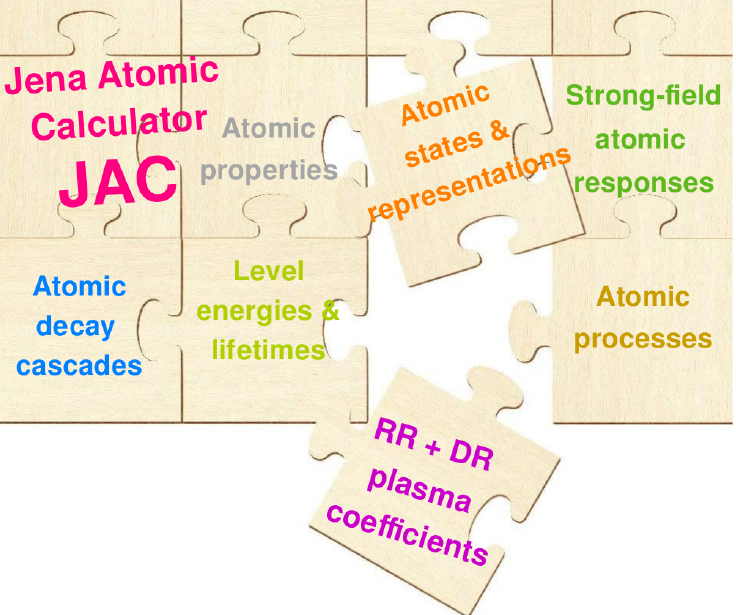
Figure 1. Selected features of the J AC toolbox [21] that help compute the level structure, processes and cascades of most atoms and ions across the periodic table. Here, emphasis has been placed on the radiative recombination of multiply charged ions and several associated plasma rate coefficients. Apart from the recombination of ions, this toolbox supports several further (relativistic) computations as briefly brought up in this jigsaw